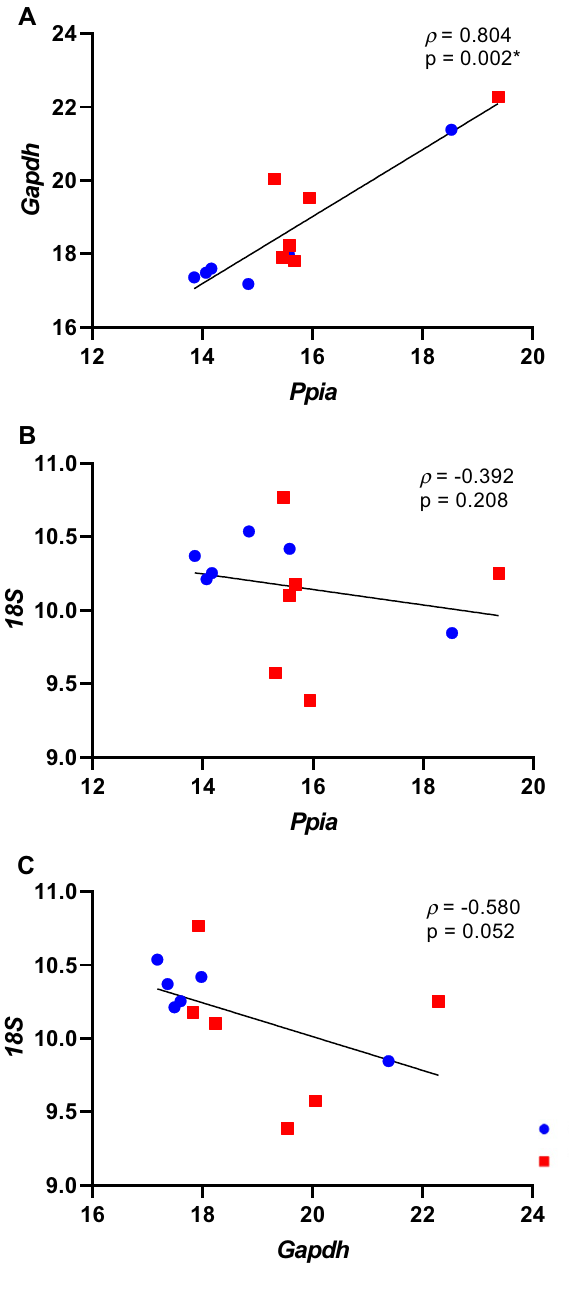
Figure 5. Correlation matrix between the expression of Ppia and Gapdh ( A ), Ppia and 18S ( B ) and Gapdh and 18S ( C ) candidate housekeeping genes. ρ : Spearman’s rank correlation coefficient. *p <